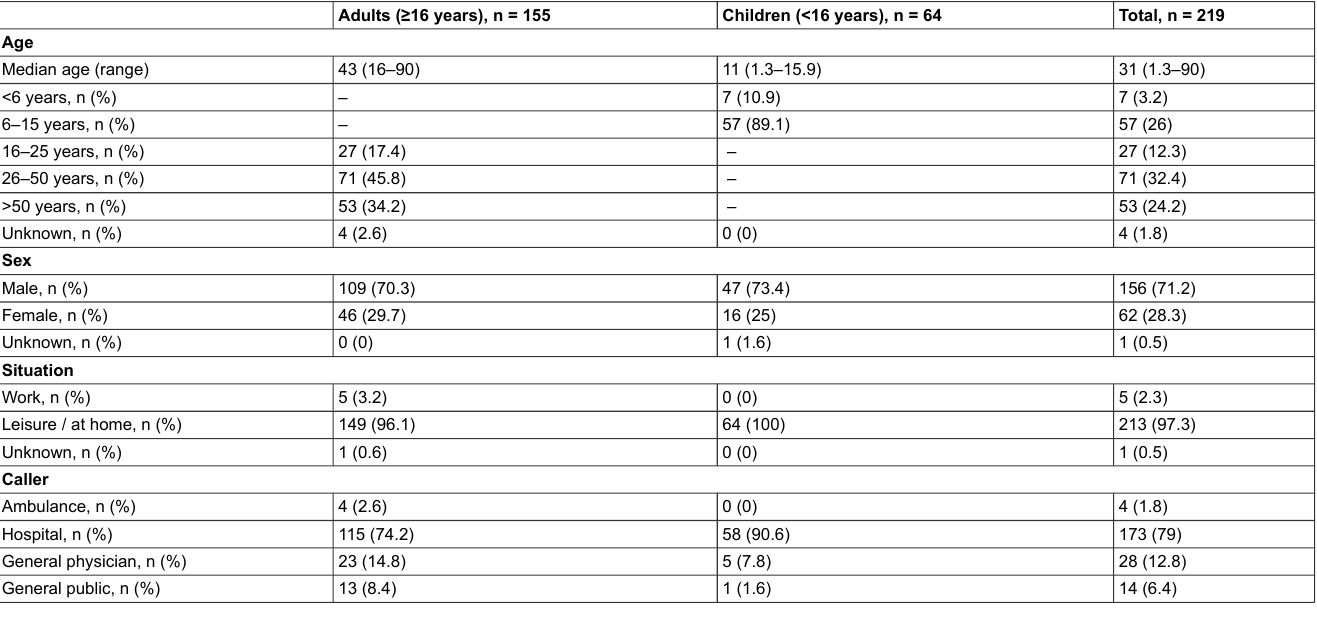
Table 1: Demographics and characteristics of patients (n =